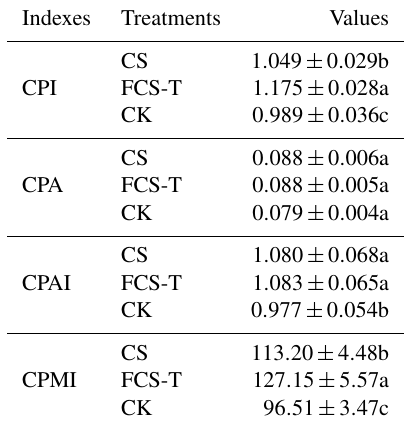
Table 4. The carbon management indices under different treatments during the 360d period. Note that mean values ± SE that do not share the same letter within a column of indexes are significantly different ( P < 0 . 05). CS, corn straw returned to the field; FCS-T, fermented corn straw treated with T. reesei returned to the field; CK, blank control treatment. CPI, carbon pool index; CPA, carbon pool activity index; CPAI, carbon pool activity index; CPMI, carbon pool management